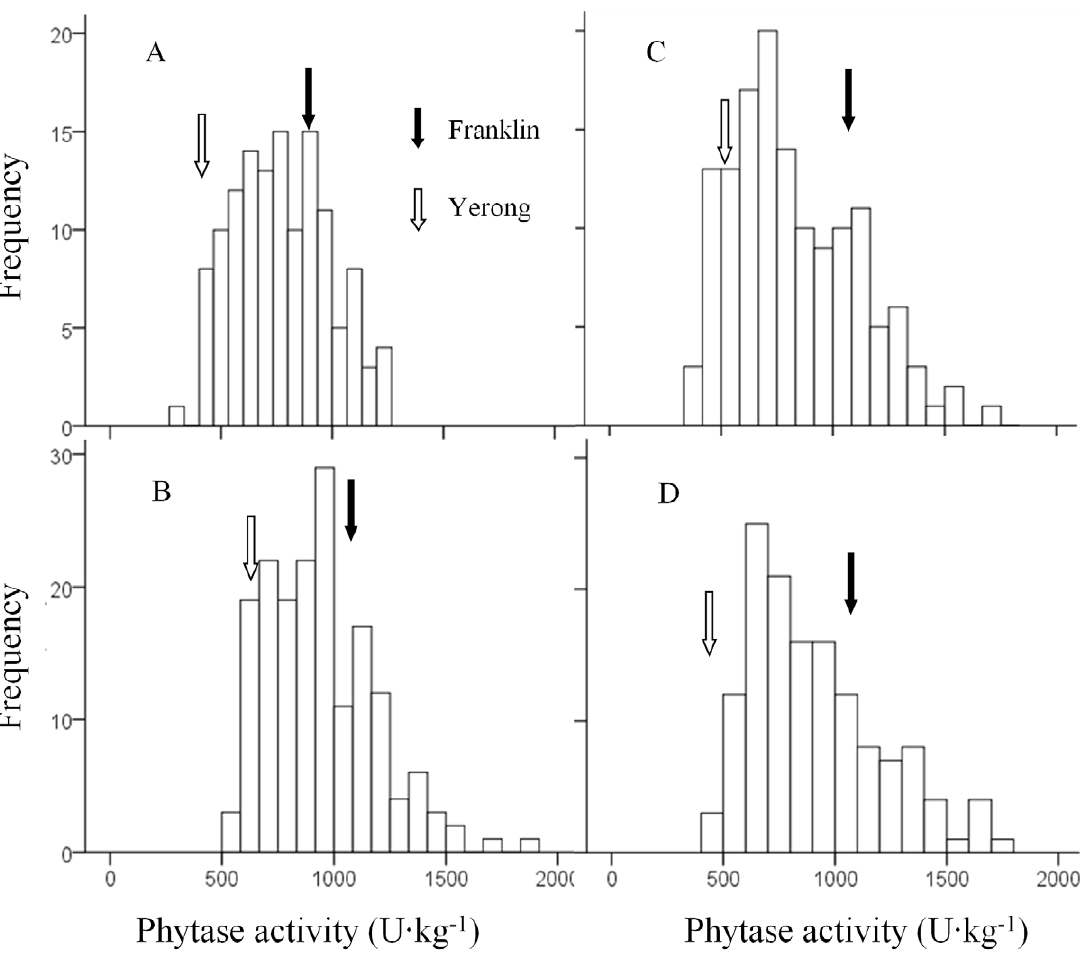
Figure 2. Frequency distribution for phytase activity in a DH population of Yerong/Franklin. A: the farm of Zhejiang University, Huajiachi campus (ZUH) in 2008–09 gorwing season; B: Forthside Vegetable Research Station (FVRS) in 2007–08 growing season; C and D: ZUH in 2009–10 growing season with High-Nitrogen (HN) and Low-Nitrogen (LN) application, respectively.